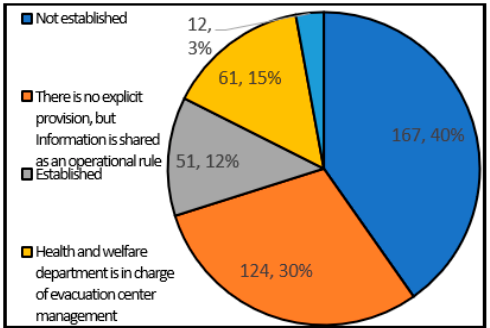
Figure 16. Information sharing with health and welfare departments (single answer) (single answer, total number of answers 415, total number of local governments: 415, unit: group).